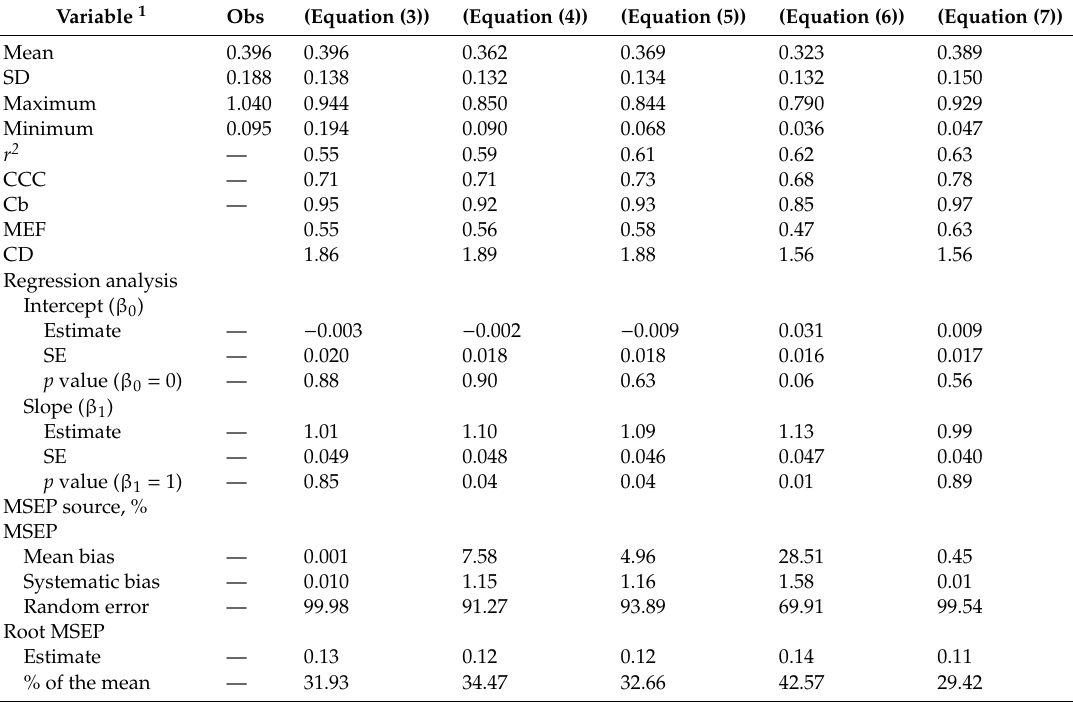
Table 4. Mean and descriptive statistics of the accuracy and precision of the equations for predicting milk yield based on udder measurements and udder volume versus the observed milk yield in Pelibuey